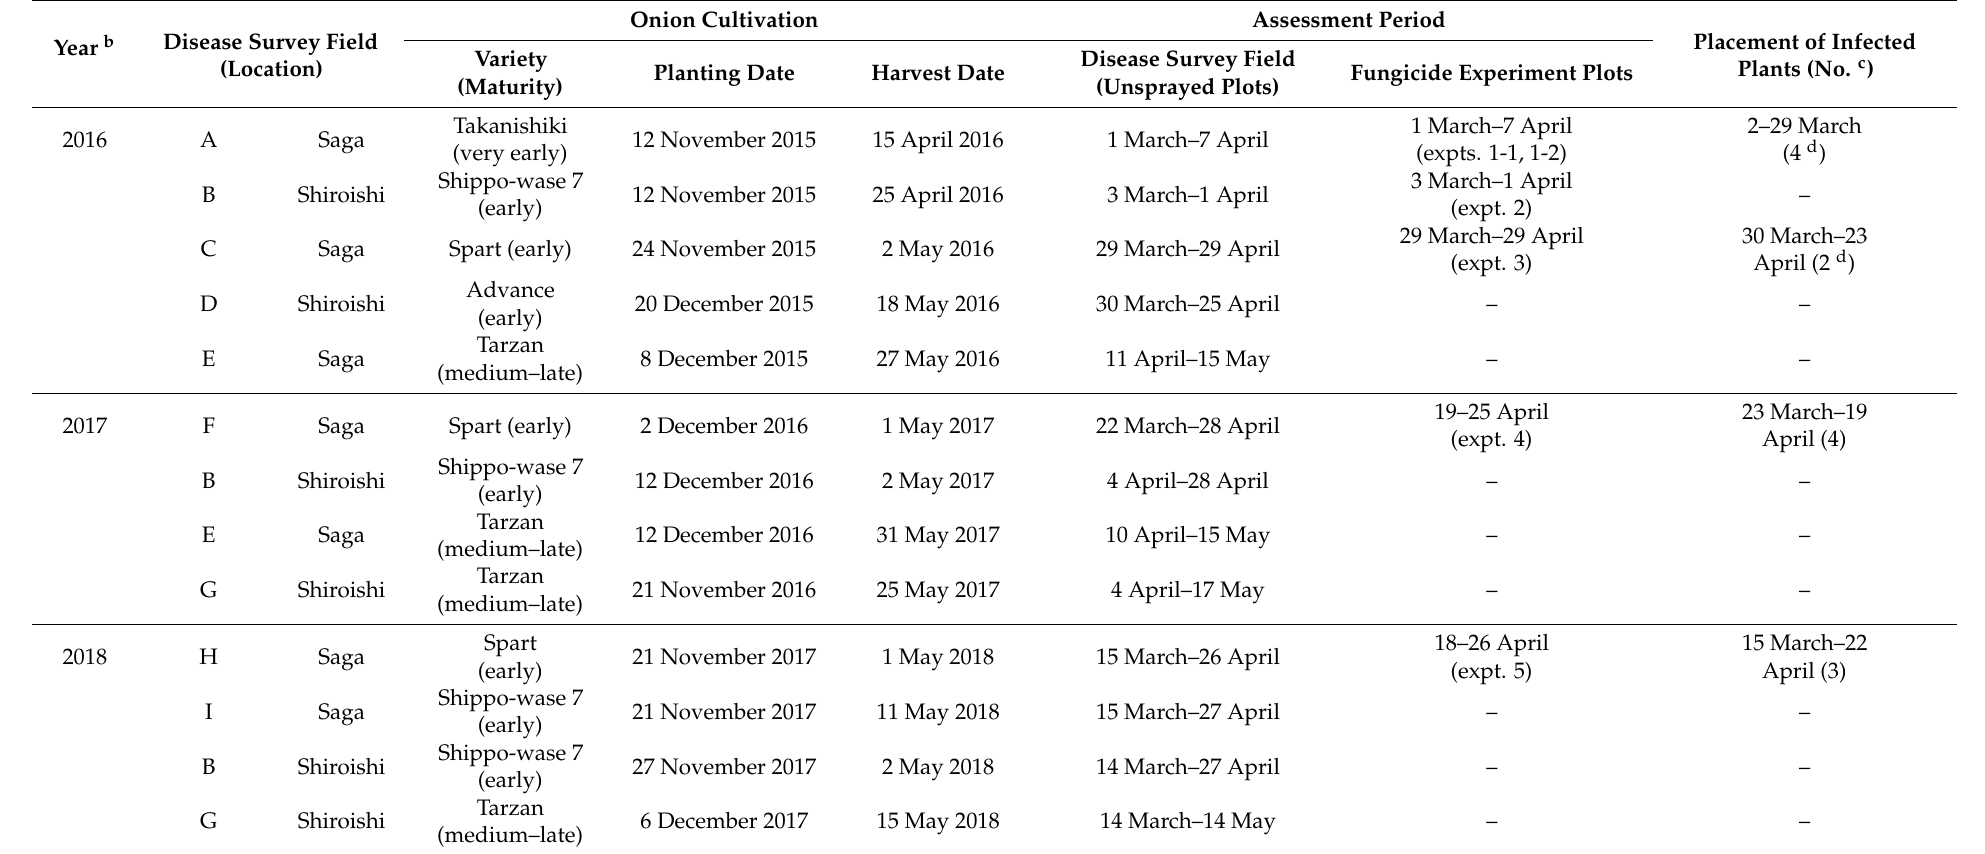
Table 1. Onion cultivation and disease assessment of onion downy mildew in the disease survey fields a